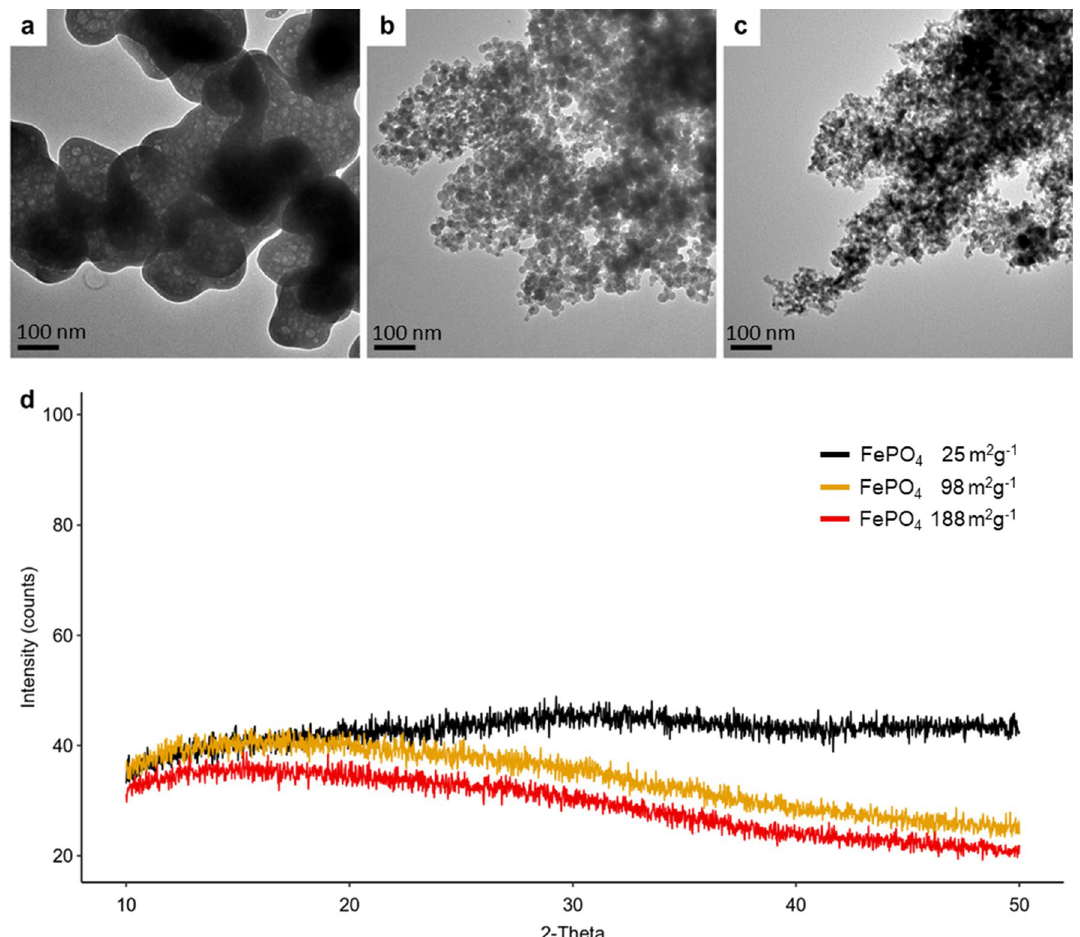
Figure 1. Particle characterization. (a–c) TEM micrographs of (a) bulk FePO 4 , (b) 98 m 2 g −1 FePO 4 and (c) 188 m 2 g −1 FePO 4 , scale bars: 100 nm. ( d) XRD patterns of 25 m 2 g −1 , 98 m 2 g −1 and 188 m 2 g −1 FePO 4 . The absence of peaks in the X-ray diffraction (XRD) analysis indicates that all compounds were XRD amorphous. X-axis indicates the diffraction angle (2-Theta), Y-axis indicates the